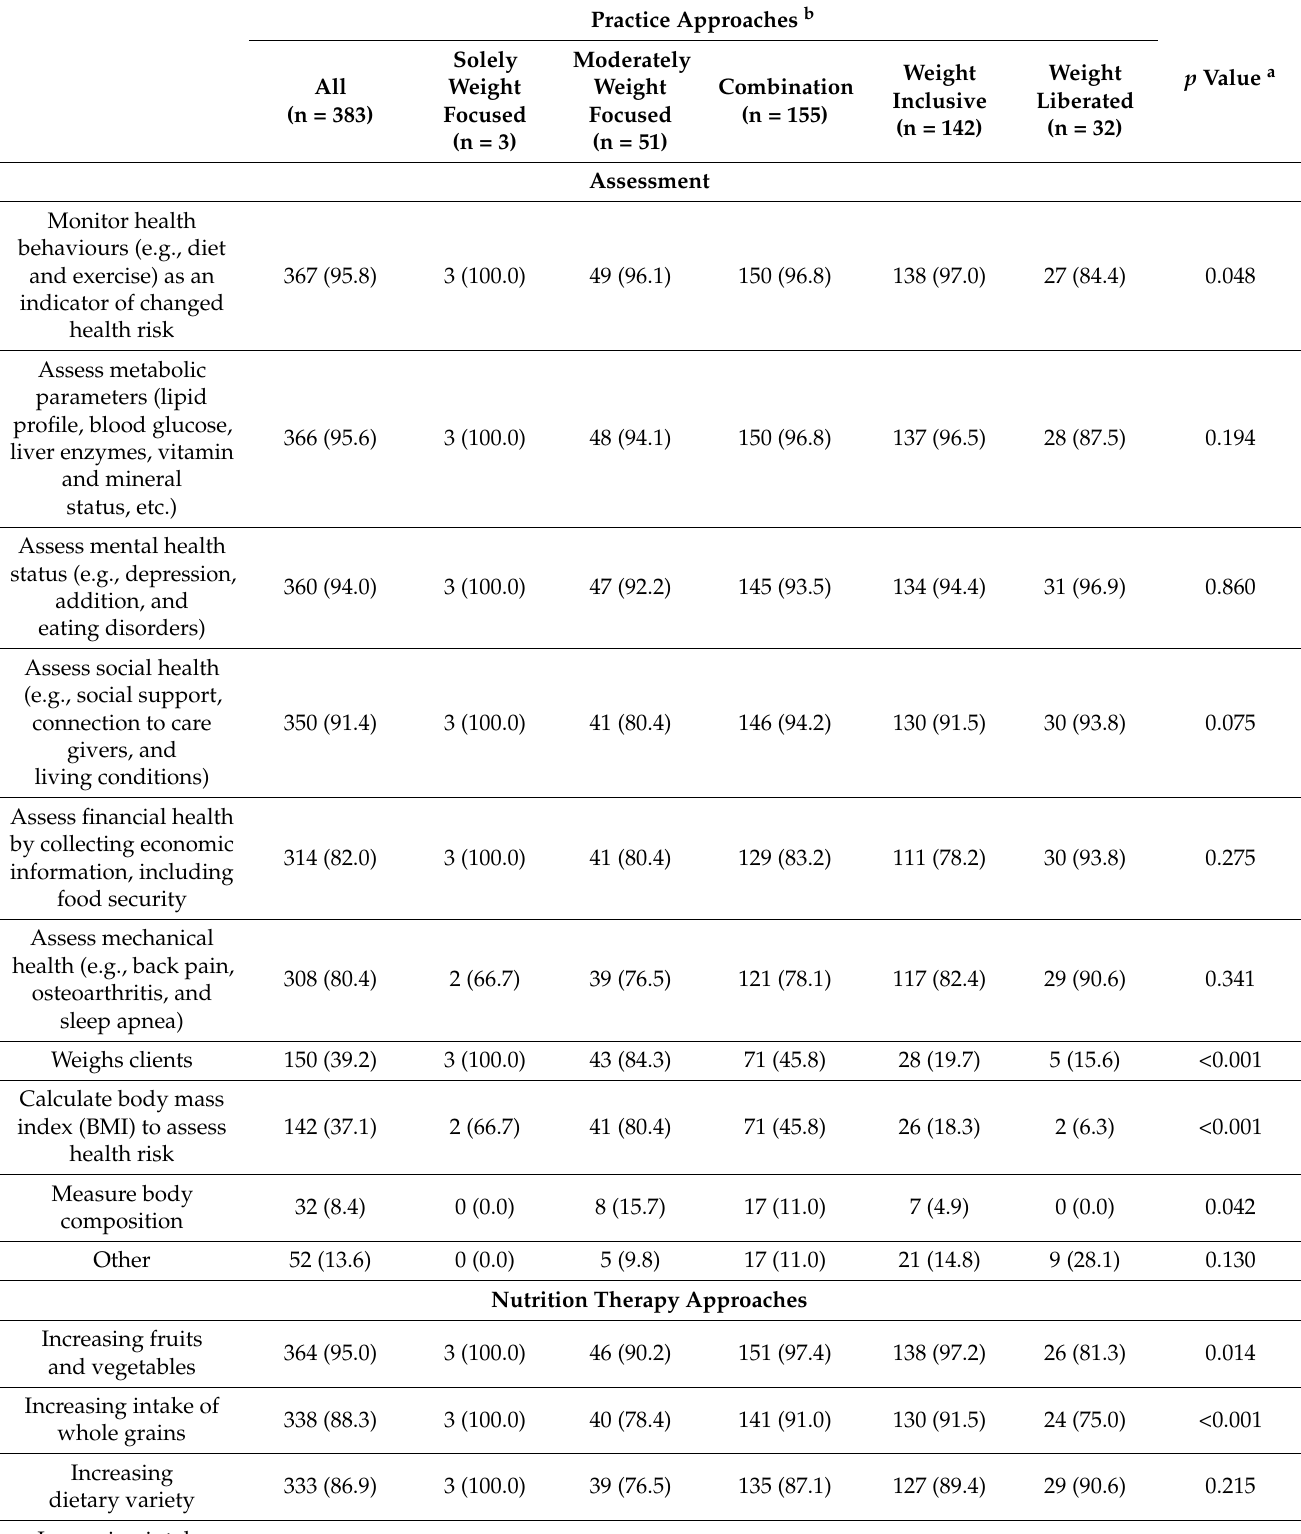
Table 5. Nutrition assessment methods, nutrition therapy approaches, and techniques commonly used by participants, overall and by practice